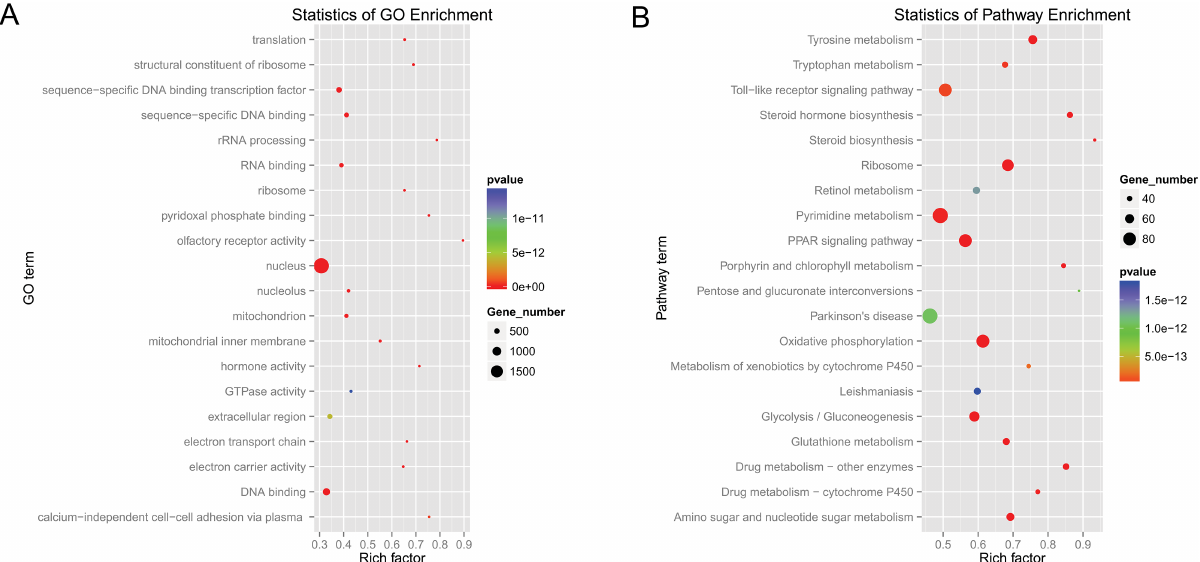
Fig 9. The top 20 enriched GO terms (A) and KEGG pathways (B). Gene number: number of target genes in each term or pathway. Rich factor: the ratio of the number of target genes dividedby the numberof all the genes in each term or pathway.